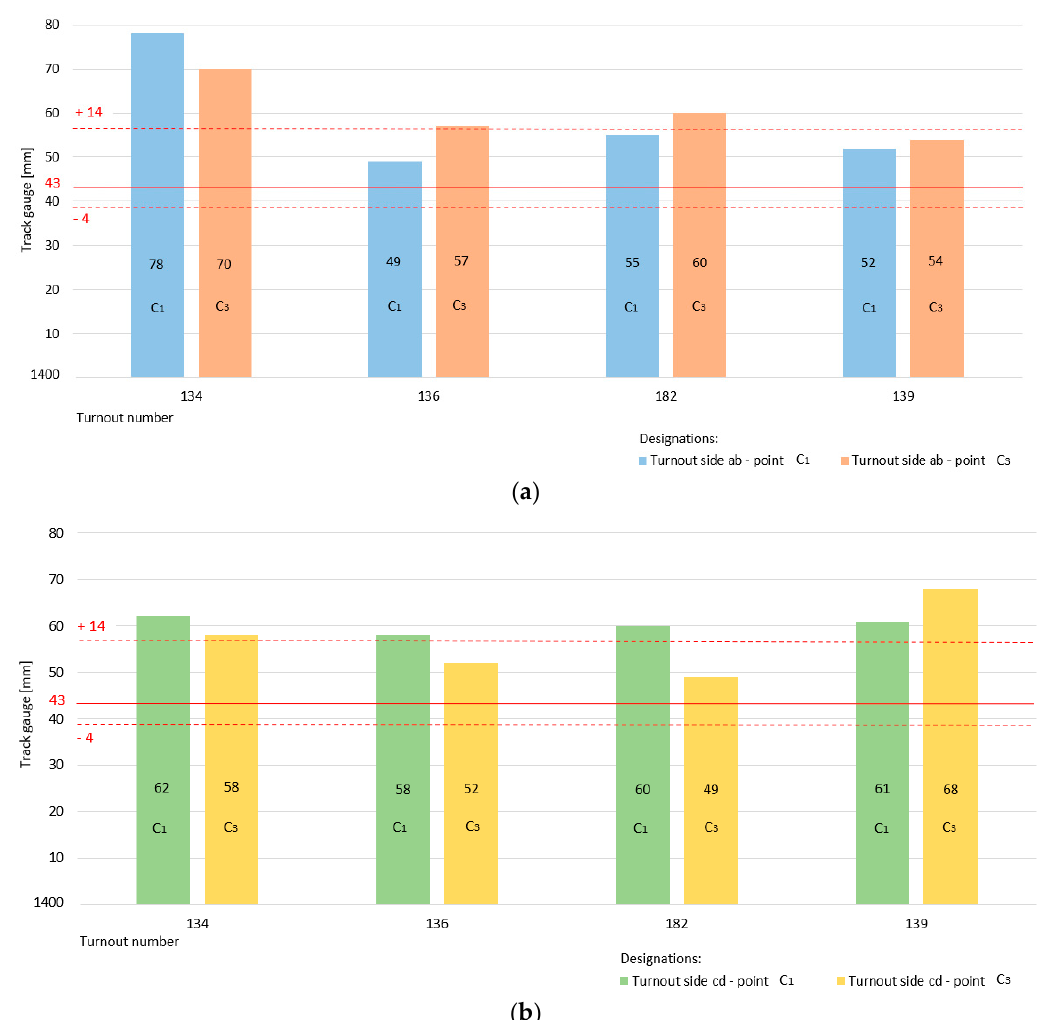
Figure 14. The track gauge of the diverted track in turnout numbers 134, 136, 182, and 139: ( a ) turnout side “ab” (measurement at c 1 , c 3 ); ( b ) turnout side “cd” (measurement at c 1 , c 3 ).